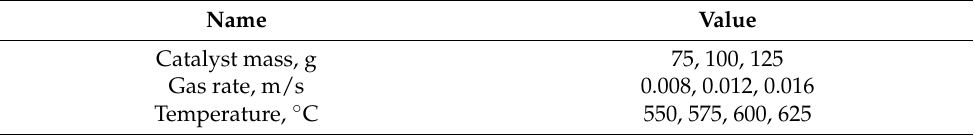
Table 1. Experiment